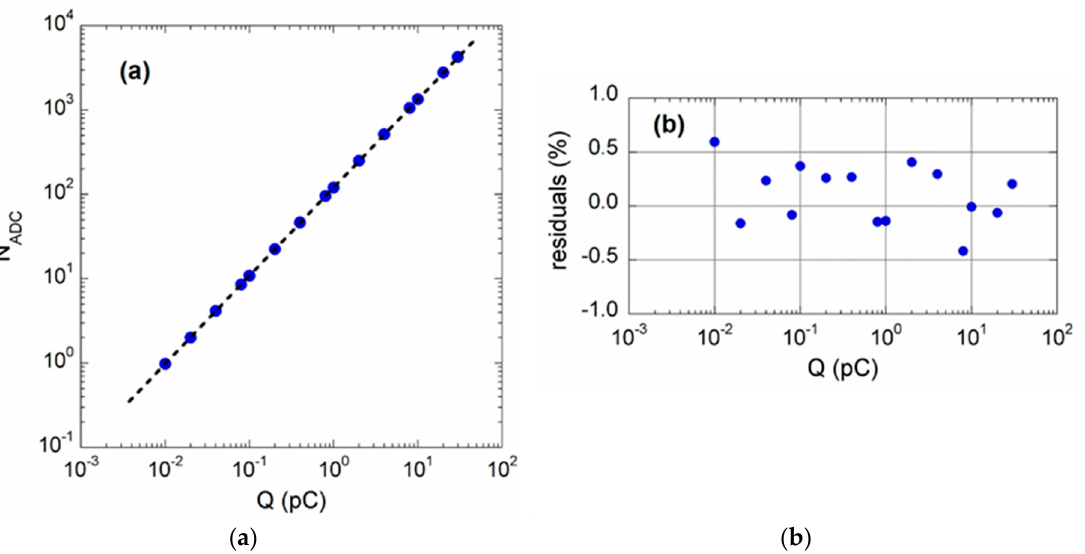
Figure 10. ( a ) ADC output as a function of the charge packets injected by a precision current source (Keithley 6221). Each data point (blue dots) is obtained as the average of 512 successive pulses. The dotted line represents linear fit of experimental data. ( b ) The residuals were calculated by the difference of experimental ADC values and those calculated by linear best fit of data.